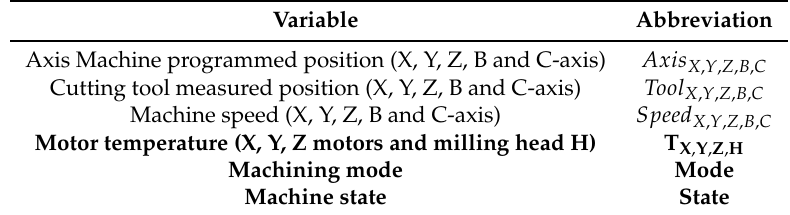
Table 1. Dataset attributes and output with their variation range. The inputs and outputs and their abbreviations in the dataset are summarized; the output variables are outlined in